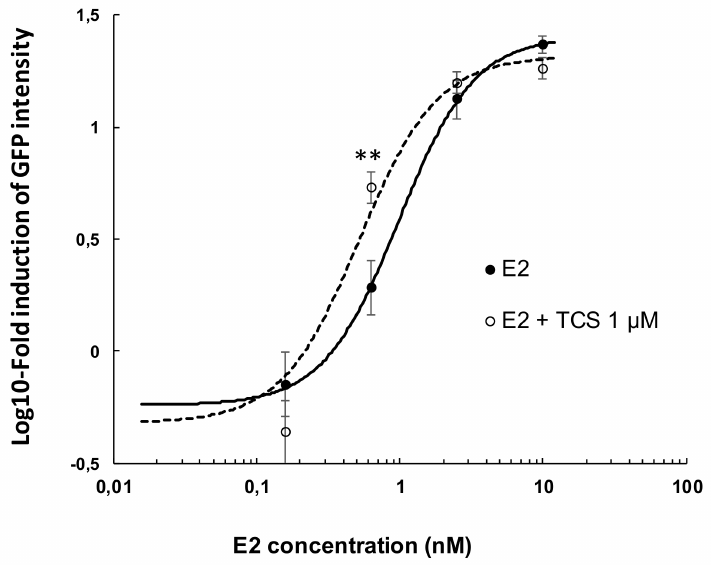
Figure 5. Effect of E2 from 0.16 to 10 nM alone (solid line) or in the presence of TCS 1 µ M (dashed line) on cyp19a1b expression in transgenic zebrafish embryos. Data represent mean of log-10 transformed fold induction values ± SEM (**: significant difference at p < 0.01, Mann–Whitney test). N = 2 independent experiments with n = 20 embryos per condition per